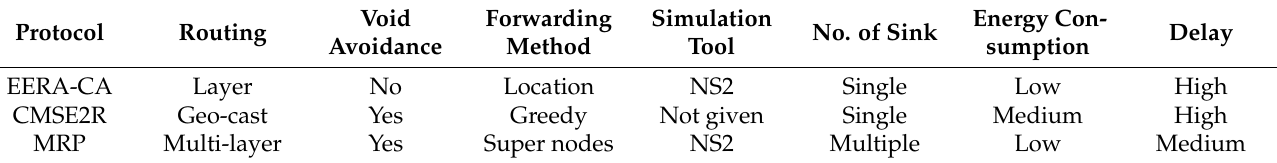
Table 15. Comparison of cluster-based routing protocol.